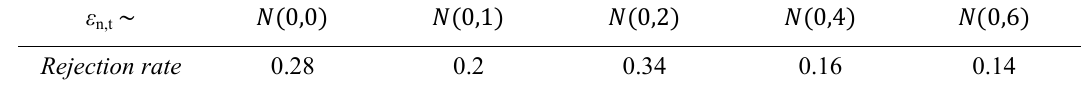
Table 9 . Rejection rates for alternative agent-specific cost innovations